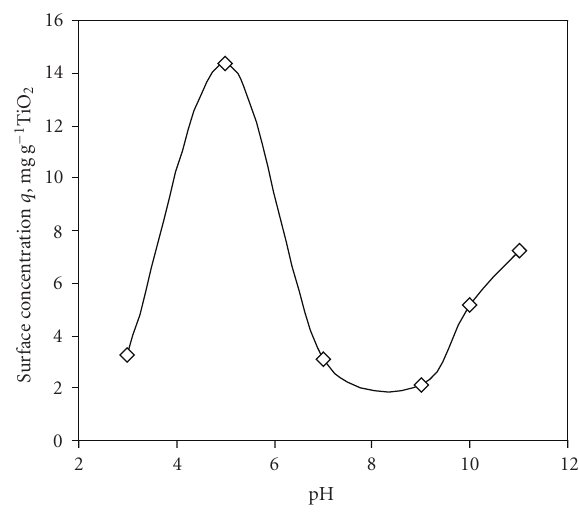
Figure 5: Saccharose equilibrium surface concentration on TiO 2 catalyst versus pH: initial concentration of saccharose 250mg L − 1